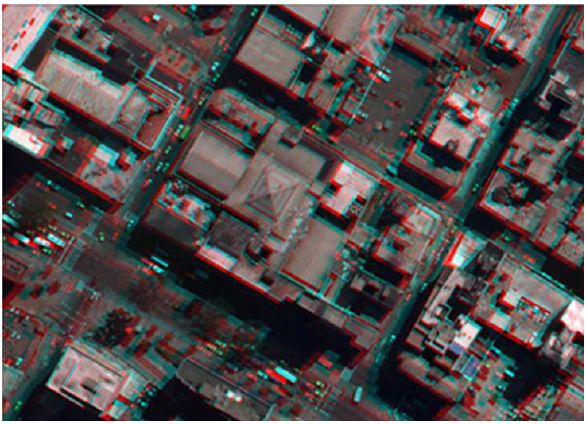
Figure 1. Stereoscopic design of a part of working area in Bogotá to be seen in third dimension through the anaglyphs system. Source: